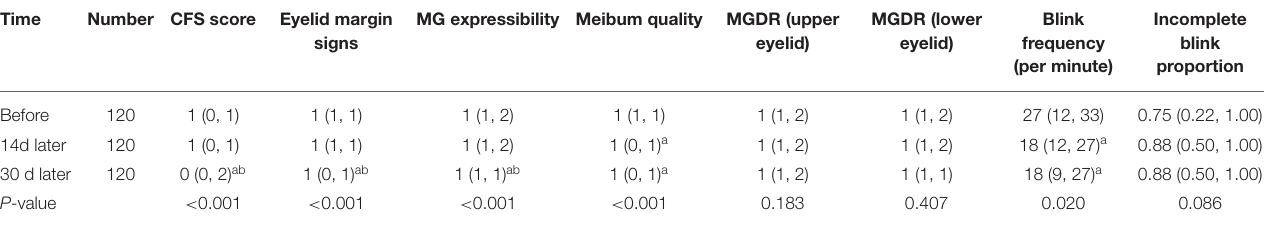
MGDR (lower eyelid)